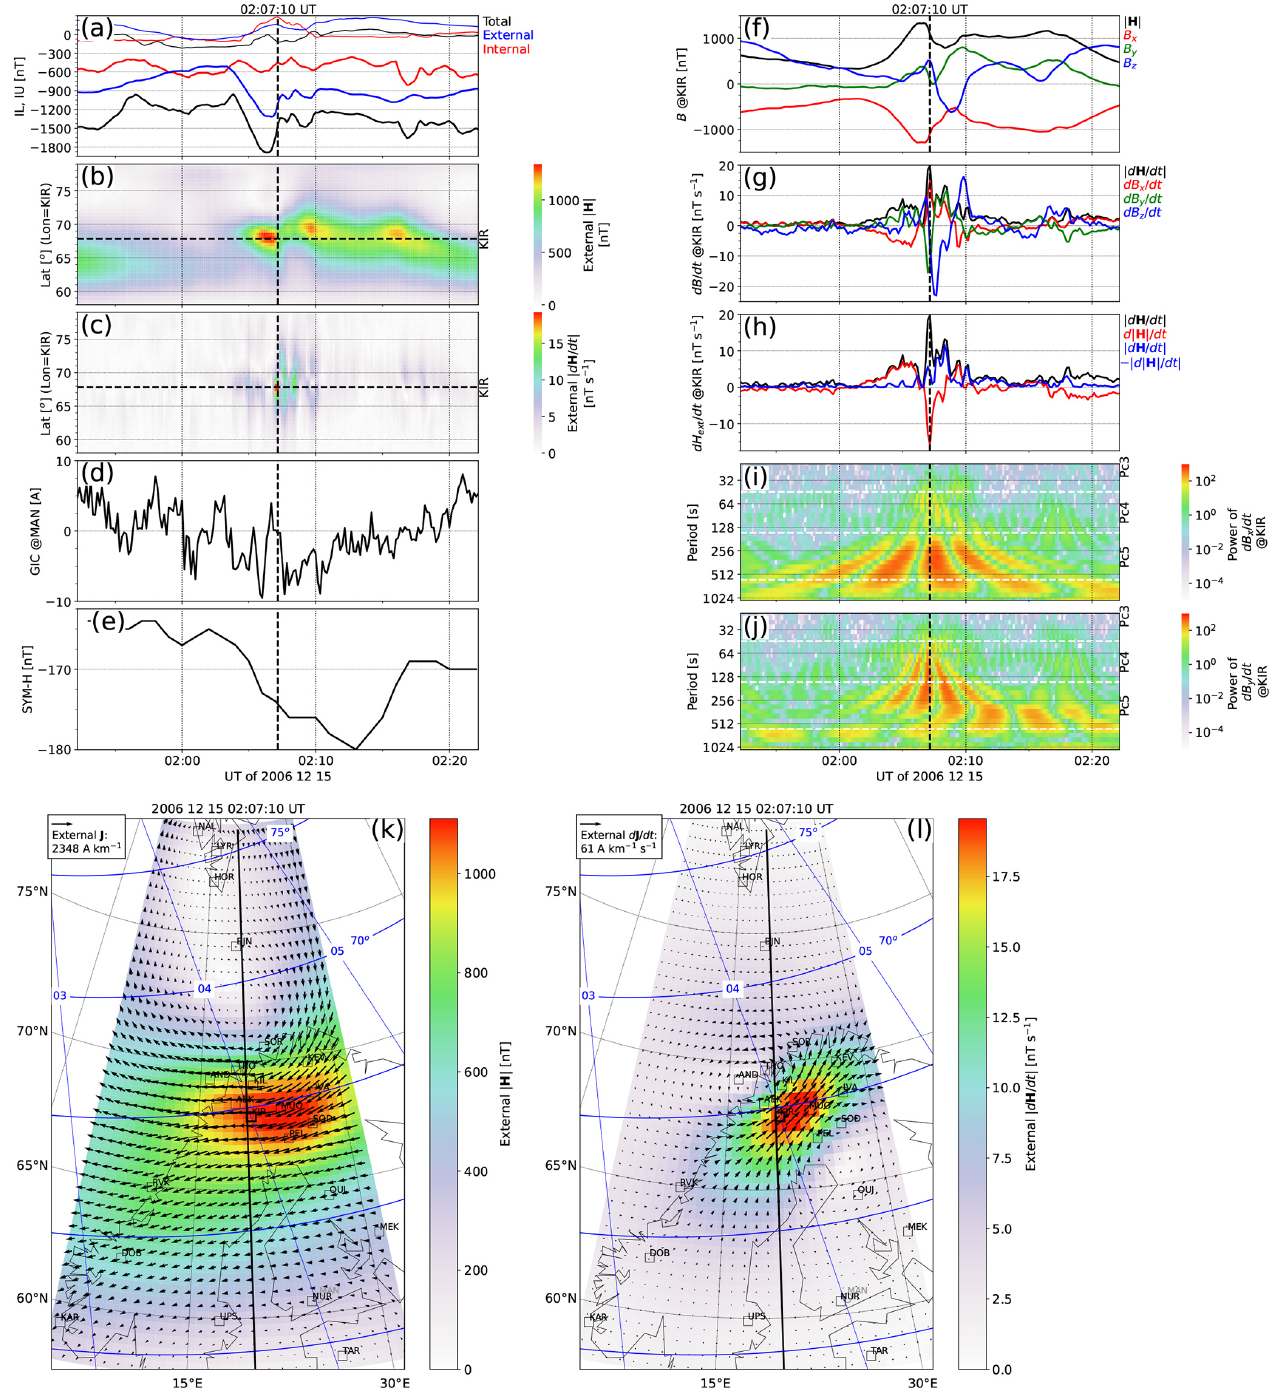
Figure 9. Data in a format similar to Fig. 5 ± 15min around the event on 15 December 2006 at